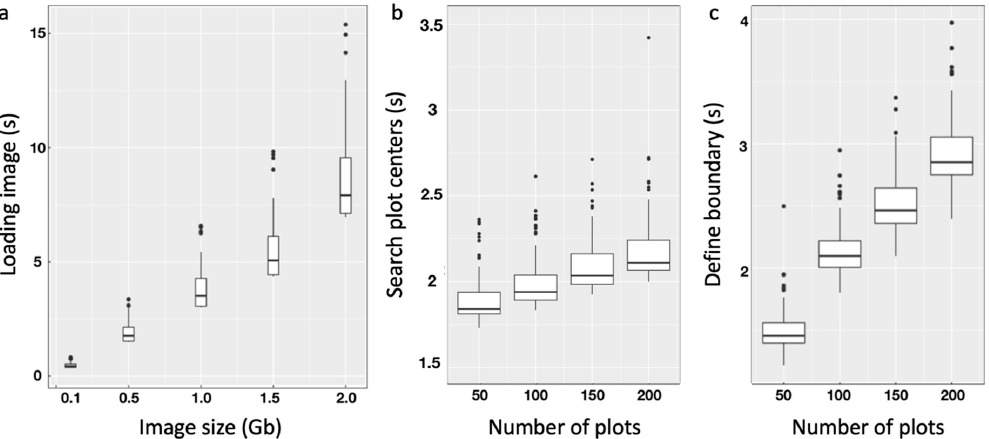
Figure 7. Linear computing complexity over file size and the number of plots. The total running times in seconds (s) were divided into times (s) for loading images ( a ), searching plot centers ( b ), and defining boundaries ( c ). The image loading time is linear to the image size. The running times for both searching plot centers and defining boundaries through bargaining between adjacent plots are linear to number of plots.